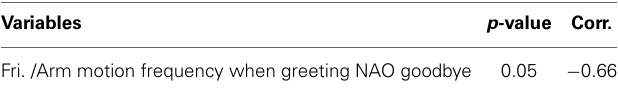
Table 3 | Spearman correlations between feeling frightened (Fri.) during the interaction with the robot, and the arm motion frequency when reacting to NAO greeting goodbye.